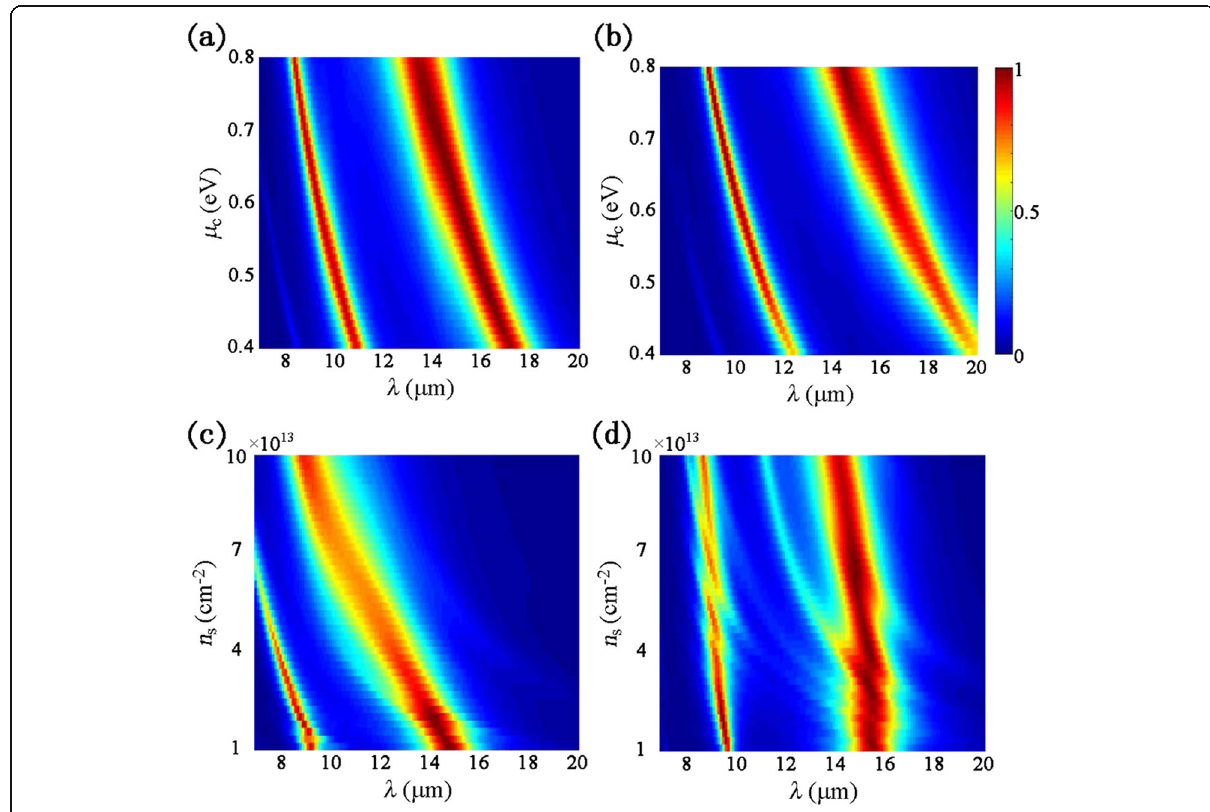
Fig. 4 Absorption spectra versus different doping levels under normal incidence: a and b for varied chemical potentials of graphene, c and d for varied carrier densities of BP, a and c for TE polarization, and b and d for TM polarization, where a = 62 nm, b = 100 nm, t d = 1.35 μ m, t = 5 nm, and P = 250